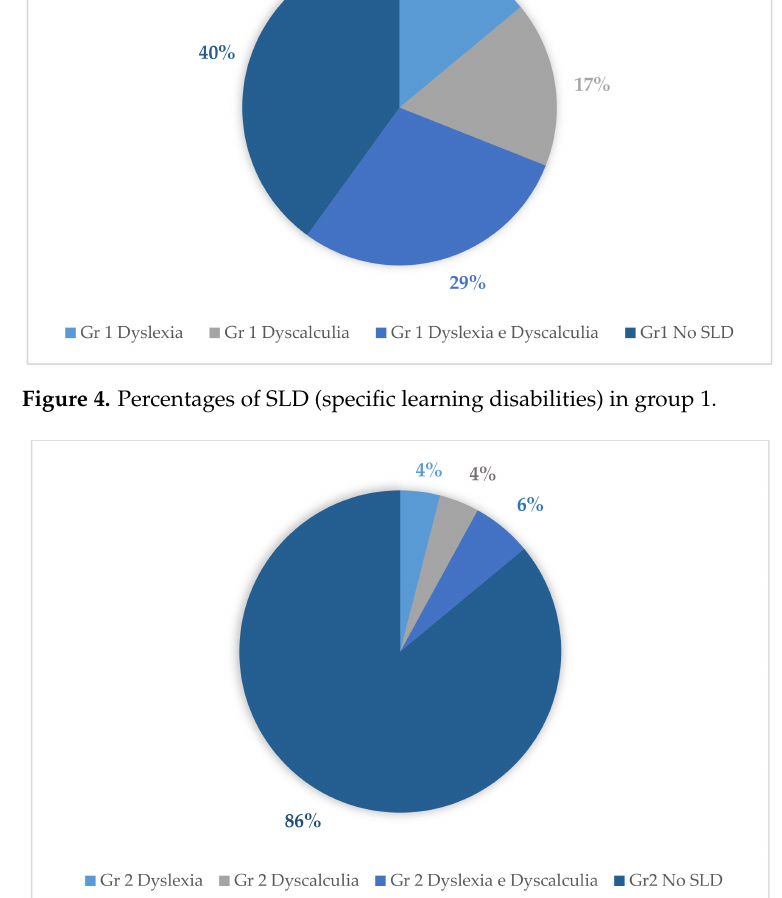
Figure 5. Percentages of SLD in group